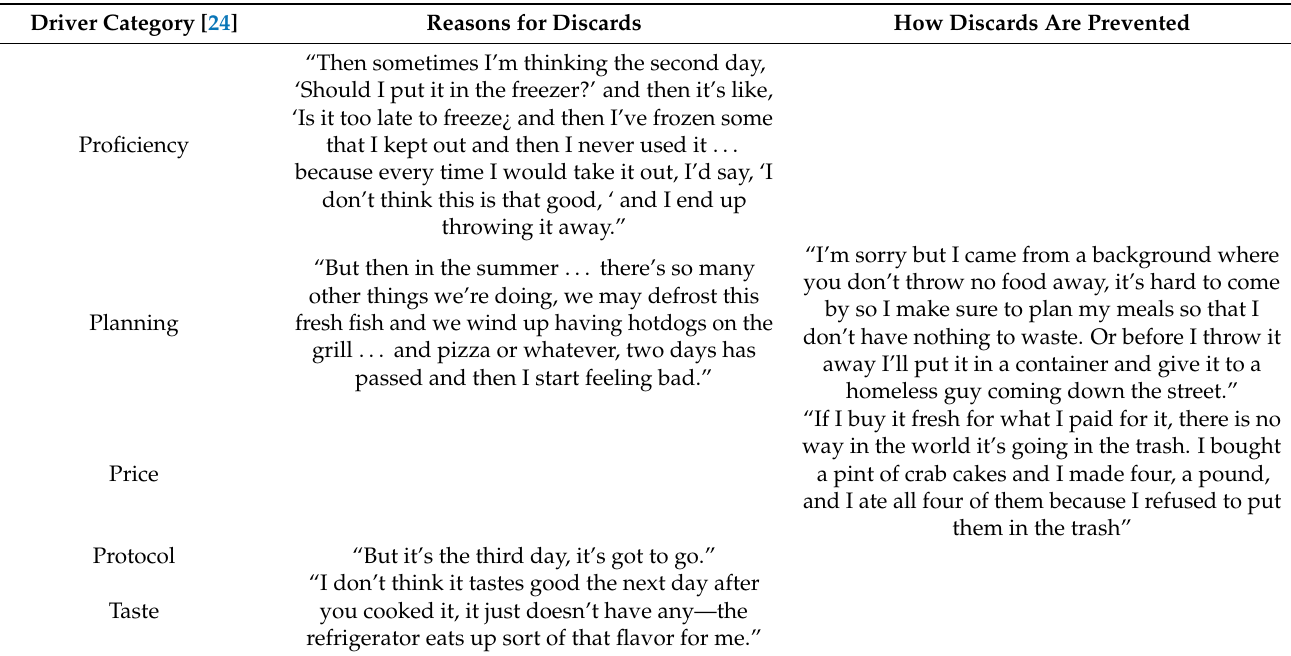
Table 3. Reasons for discarding seafood and how discards are prevented. Focus group illustrative quotes. Driver Category [24] Reasons for Discards How Discards Are